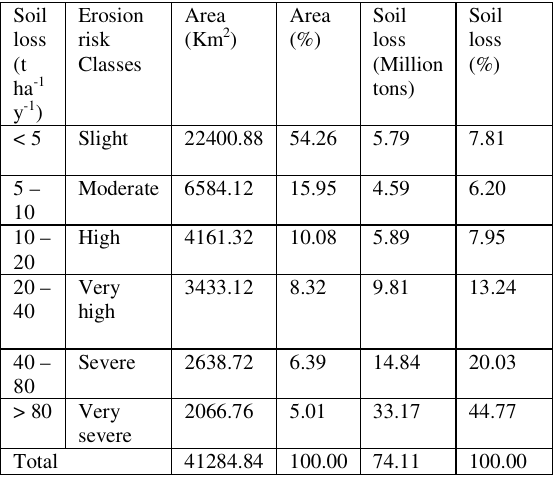
Table 2. Soil loss and erosion risk classes